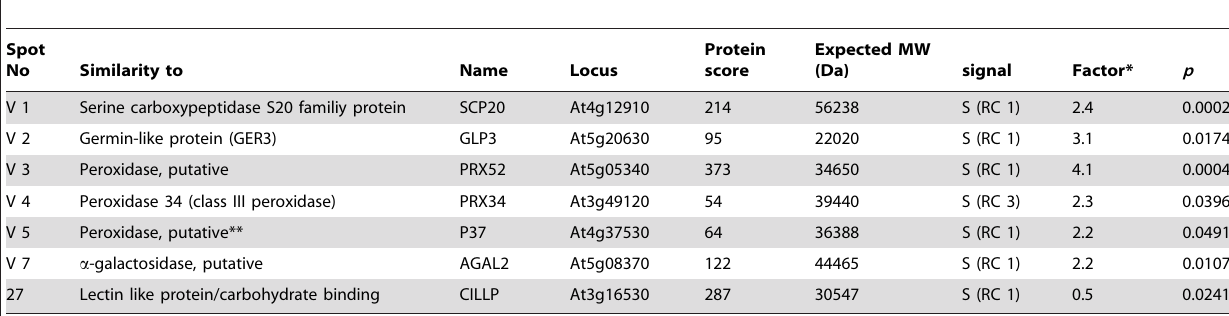
*Factor: protein abundance in samples of VL-treated plants/protein abundance in mock-inoculated plants, **92% homology to PRX At437520. Only those spots were analyzed that were reproducibly observed in two independent experiments. In each experiment three biological replicates were analyzed. For further details, see Table 4. Spot identification numbers refer to those shown in Figure 1. Peptides are shown in Table S1.